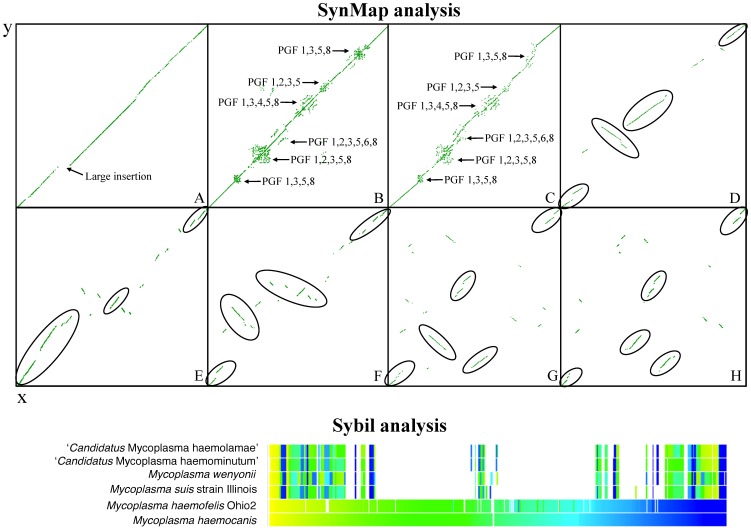
Syntenic maps of hemoplasma genomes.Plots were generated using comparative genomics suite CoGe SynMap and Sybil tool. In the SynMap analysis, each dot represents a matching gene pair. A) y-axis: M. suis Illinois, x-axis: M. suis KI3806; arrow indicates a 39,820 nt insertion in M. suis strain Illinois B) y-axis: M. haemofelis Langford1, x-axis: M. haemofelis Ohio2 C) M. haemocanis Illinois x-axis: M. haemofelis Ohio2 D) y-axis: ‘Candidatus M. haemominutum’ Birmingham1, x-axis: M. suis Illinois E) y-axis: ‘Candidatus M. haemolamae’ Purdue, x-axis: ‘Candidatus M. haemominutum’ Birmingham1 F) y-axis: ‘Candidatus M. haemolamae’ Purdue, x-axis: M. suis Illinois G) y-axis: M. wenyonii Massachussets, x-axis: ‘Candidatus M. haemominutum’ Birmingham1 H) y-axis: M. wenyonii Massachussets, x-axis: M. suis Illinois. Other comparisons, which show less conserved synteny, are not shown for simplicity. Arrows indicate expansion of paralog gene families (PGF) as numbered in M. haemofelis Ohio2 [11]. Circles indicate blocks of synteny. Sybil map used M. haemocanis as a reference genome. See Materials and Methods.